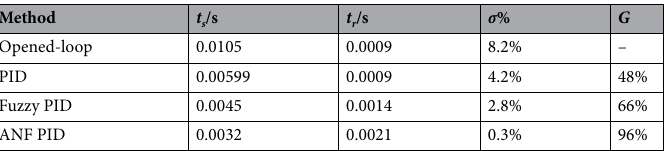
Table 5. Evaluation of small signal model. t s time to steady state, t r rise time, σ% overshoot amount, G optimization rata of overshoot.